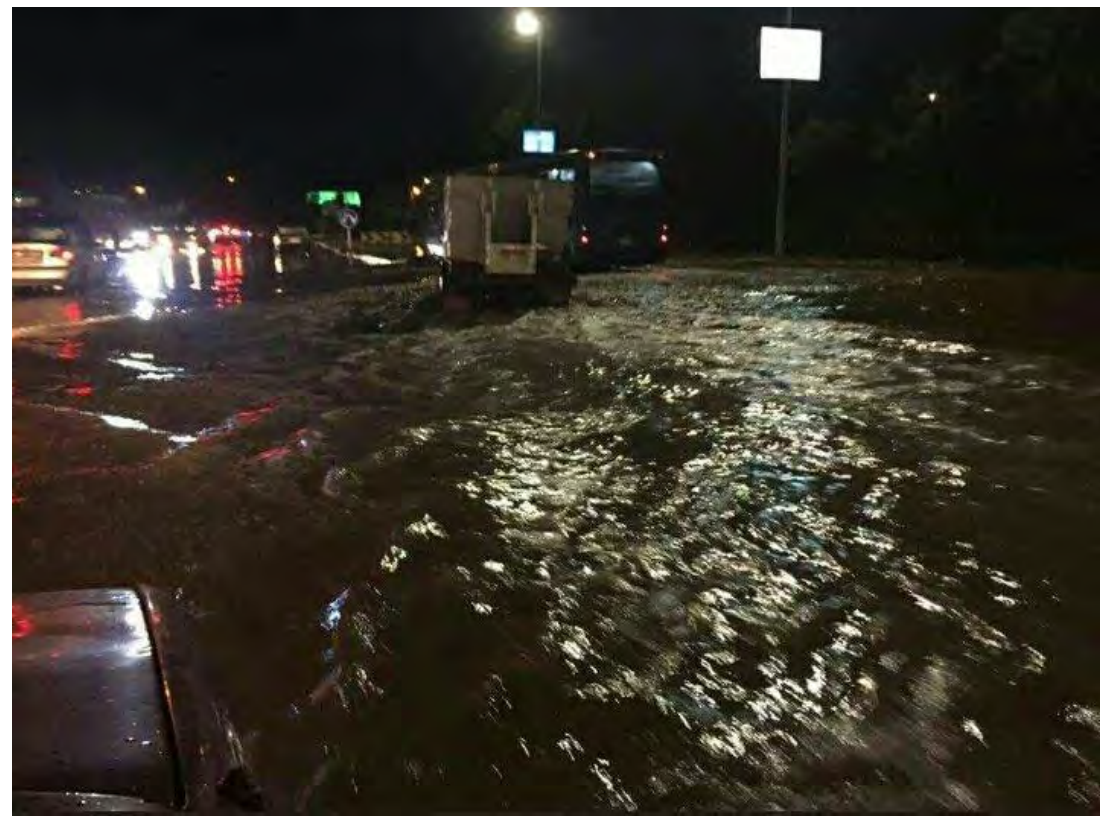
Fig.7: A high level of water. (Masrawy.com, 2018)